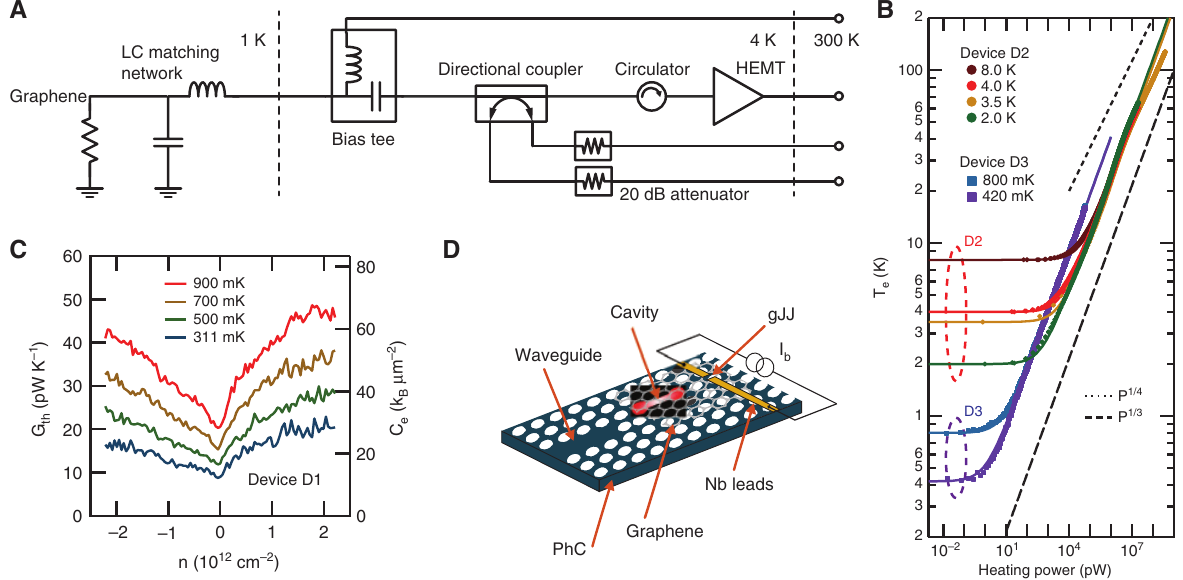
Figure 5: (A) Schematics of a graphene bolometer circuit [21, 78]. Due to its exceedingly small electronic heat capacity, the graphene sheet acts as an ultrasensitive heat absorber. The change of its electronic temperature T is read out by a Johnson noise thermometry scheme that e provides a sensitivity in the range of mK/Hz 1/2 . Here, microwave signals from the graphene are transmitted through an impedance matched LC circuit and amplified by a low noise amplifier. (B) The response of T to Joule heating. (C) The resulting electronic thermal conductance e and the electronic specific heat due to electron-phonon cooling. (D) Schematics of a proposed graphene-based single photon detector. A graphene sheet is placed on a photonic crystal cavity for maximal quantum efficiency. The graphene is proximitized by two superconducting electrodes that allow single photon read out through the Josephson